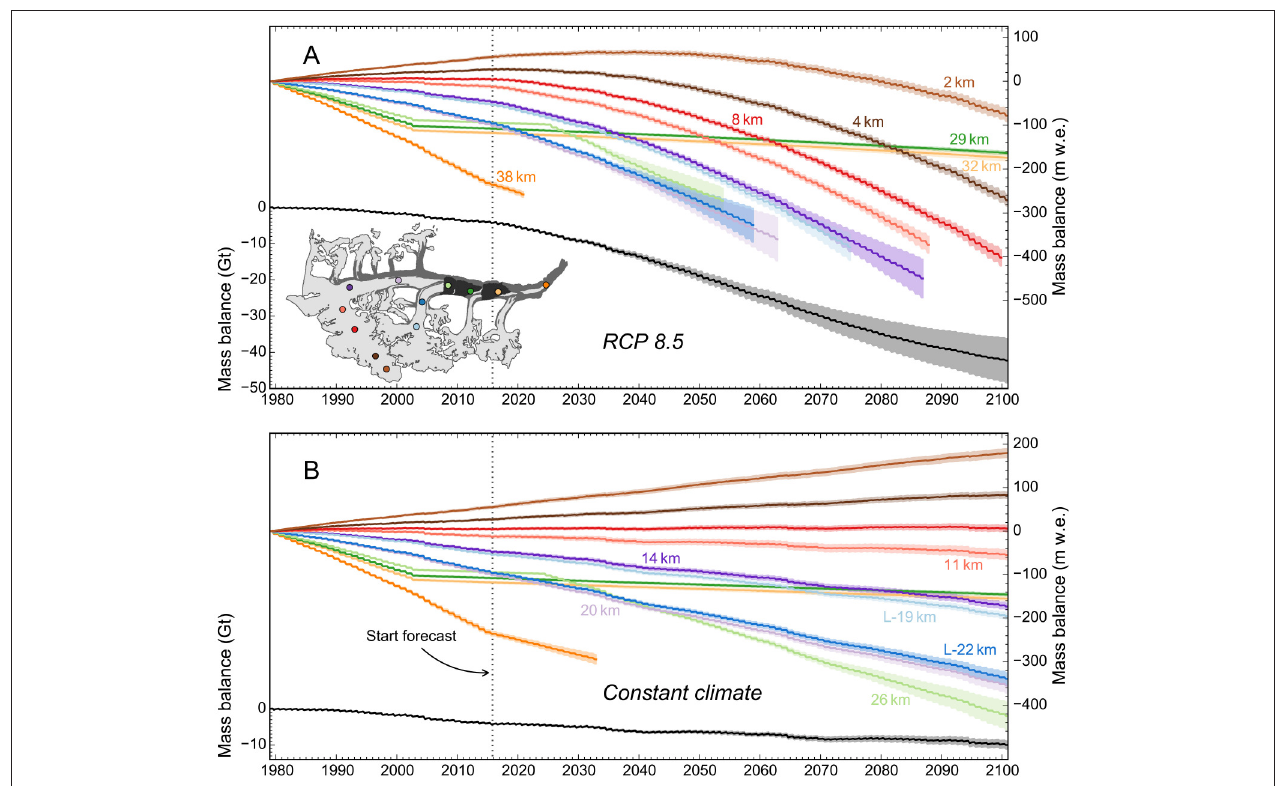
FIGURE 9 | Cumulative daily mass balances using (A) the RCP 8.5 scenario and (B) the constant climate scenario. For both scenarios, glacier-wide balances over the entire glacier (in Gt, left axis) and point balances at the index sites (in m w.e., right axis) are shown. The index sites are annotated with locations given on the inset map in (A) . Bold lines indicate the means derived from the 400 Monte Carlo runs; semi-transparent areas delimit the corresponding standard deviations. In the case of the index sites, the curves terminate once 5% of the model runs indicate ice-free conditions (an existing curve thus reflects at least 95% probability for ice at the index sites). Abruptly increasing standard deviations at selected lower-lying stakes (e.g., L-22km) are due to the fact that the stakes are debris-covered in some model runs, while not in others. Index site 38km got covered by moraine debris in 2015, so that the stake’s mass balance curve flattens with the start of the forecasting